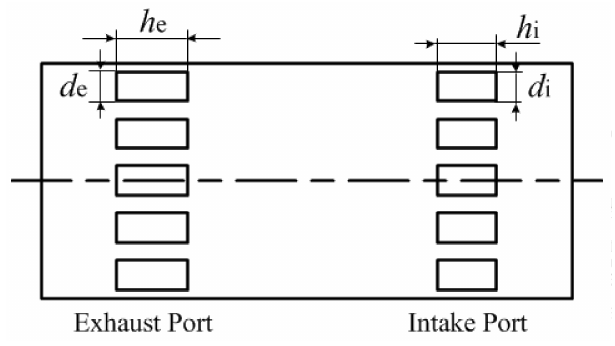
Figure 2. The port parameters.